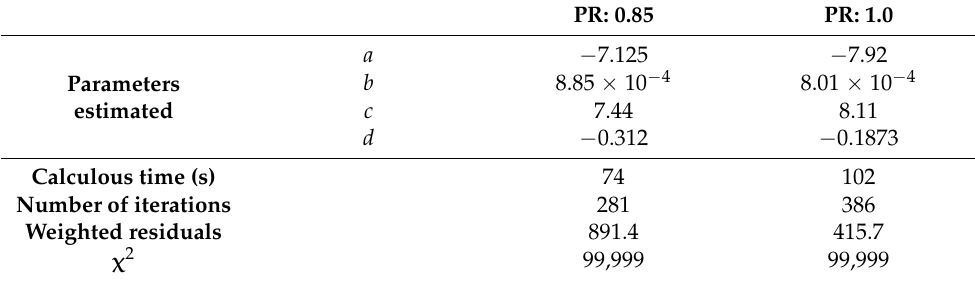
Table 7. Results of parameter